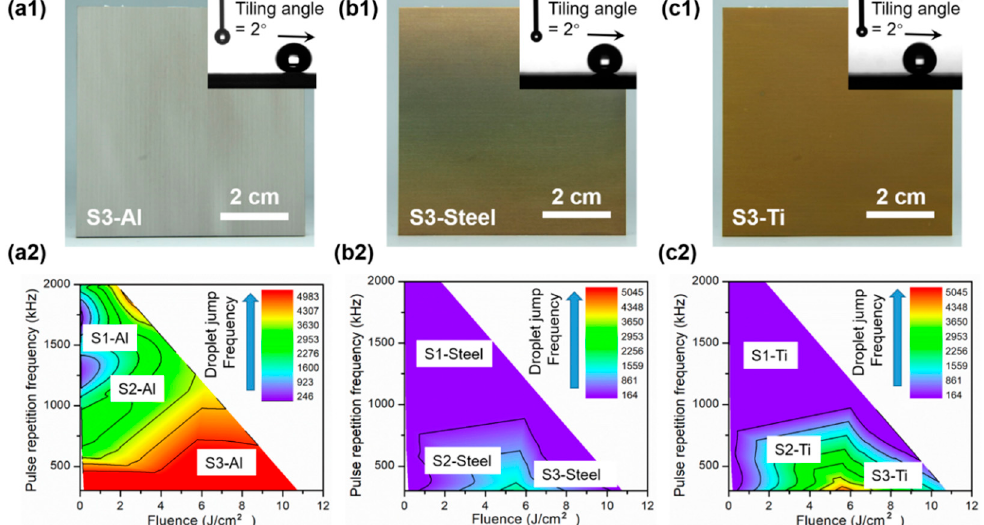
Figure 6. Ultrafast laser-constructed SHSs and condensed microdroplet behavior phase maps for other metal and metal alloy surfaces. ( a1 – c1 ) Large S3-type Al, steel, and Ti surfaces. ( a2 – c2 ) Phase maps relating laser processing parameters to the droplet jumping frequency for Al, steel, and Ti. Units for the number of removed droplets: cm − 2 ·min − 1 .